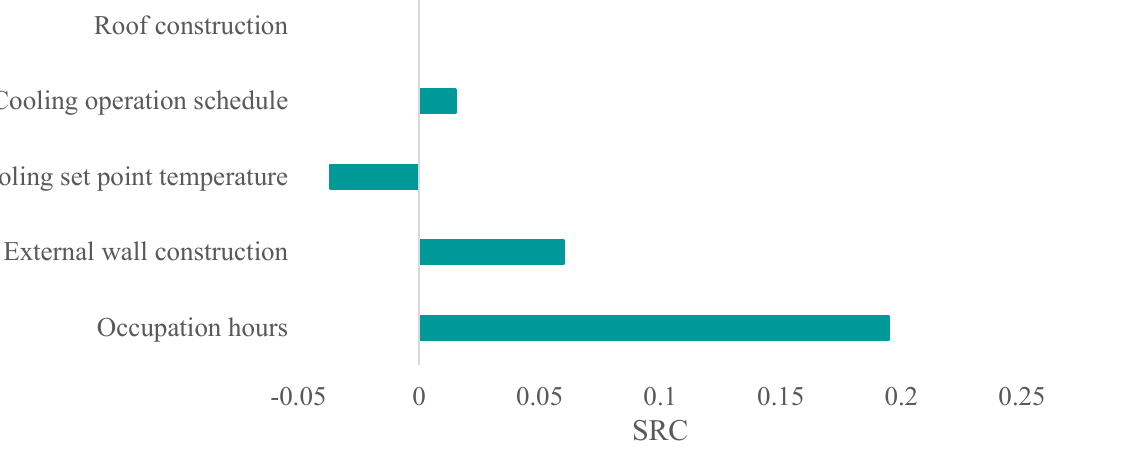
Figure 7. Design variables considered in the sensitivity analysis and their respective standardized regression coefficient.